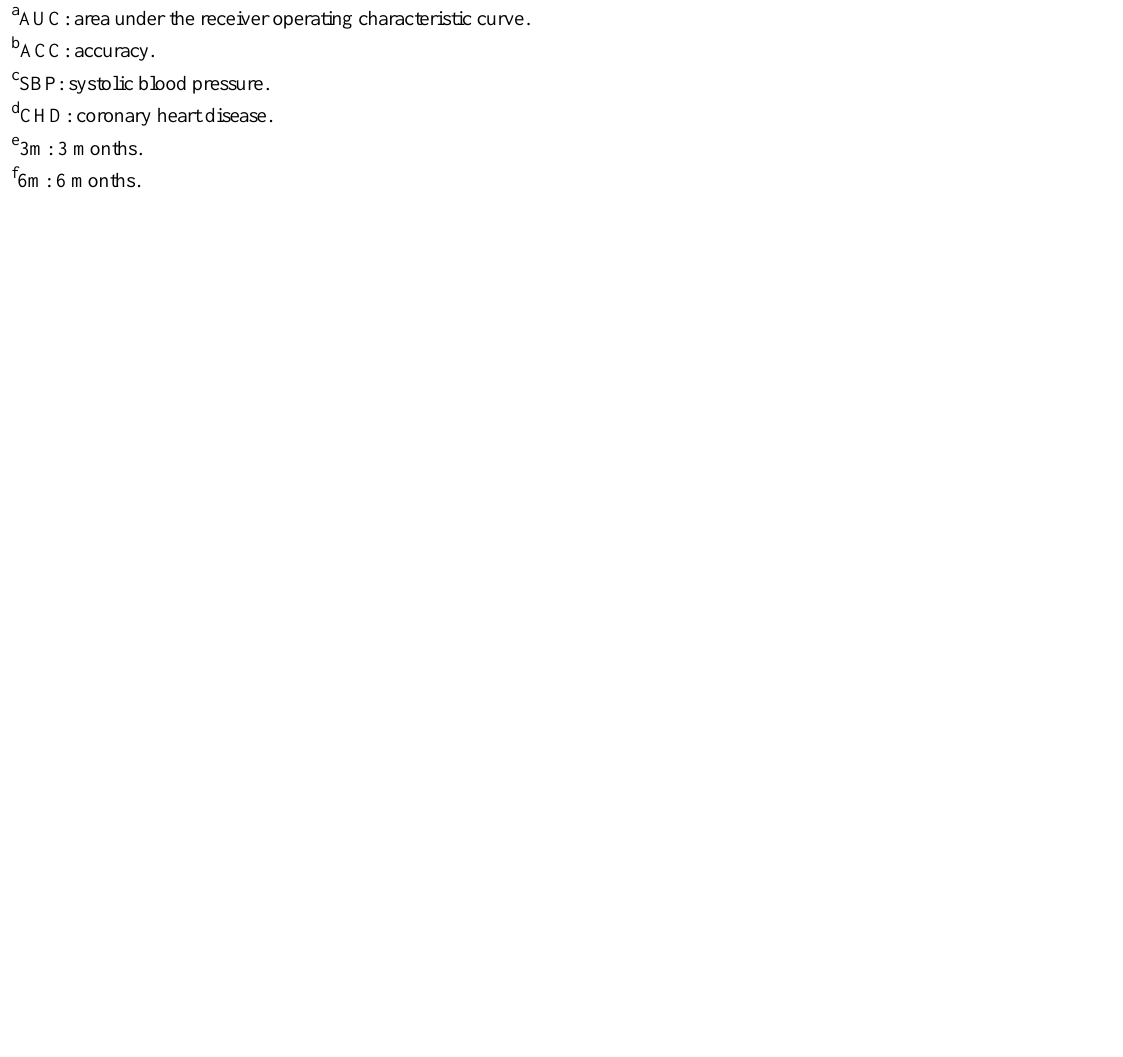
Table 5. Trends of model performance with increasing feature sets. 0.69410.75474SBP c _last, Age, Gender, Years_After_Hypertension (in the last CHD d -free